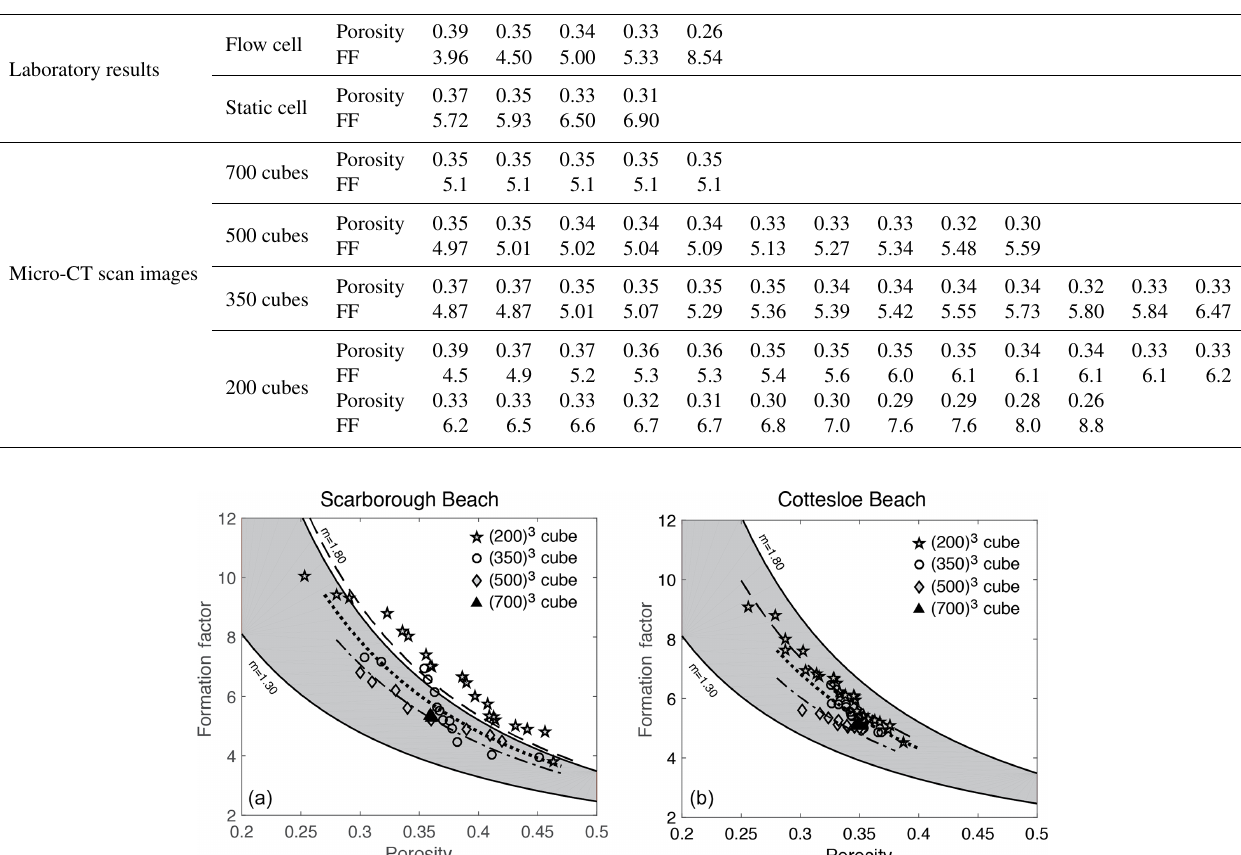
Table 2. Summary of laboratory and micro-CT scan image results from the Cottesloe Beach samples.